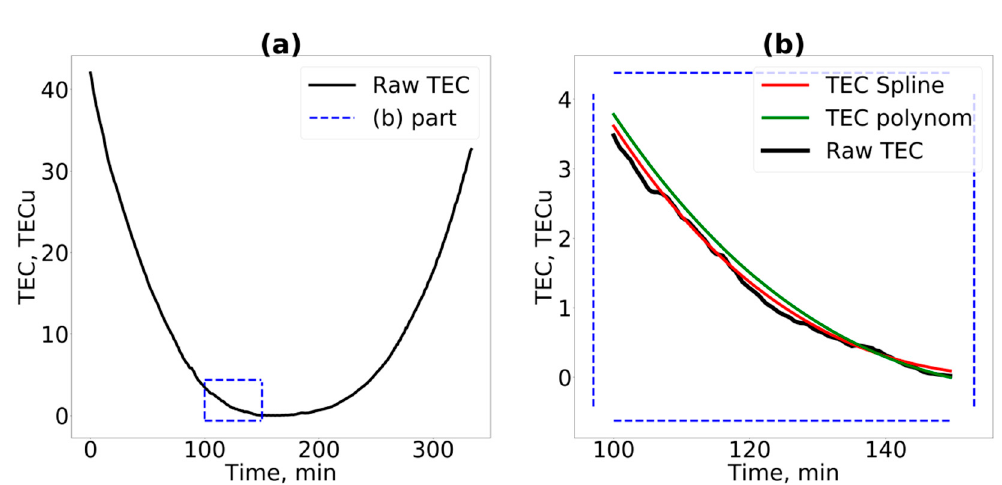
Figure 10. Raw TEC ( a ) and detalied part of Raw TEC ( b ). On the right panel red and green lines show TEC trends based on smoothing spline and polynomial, correspondingly Data from “UZUR - GPS26” on 14 April 2016.